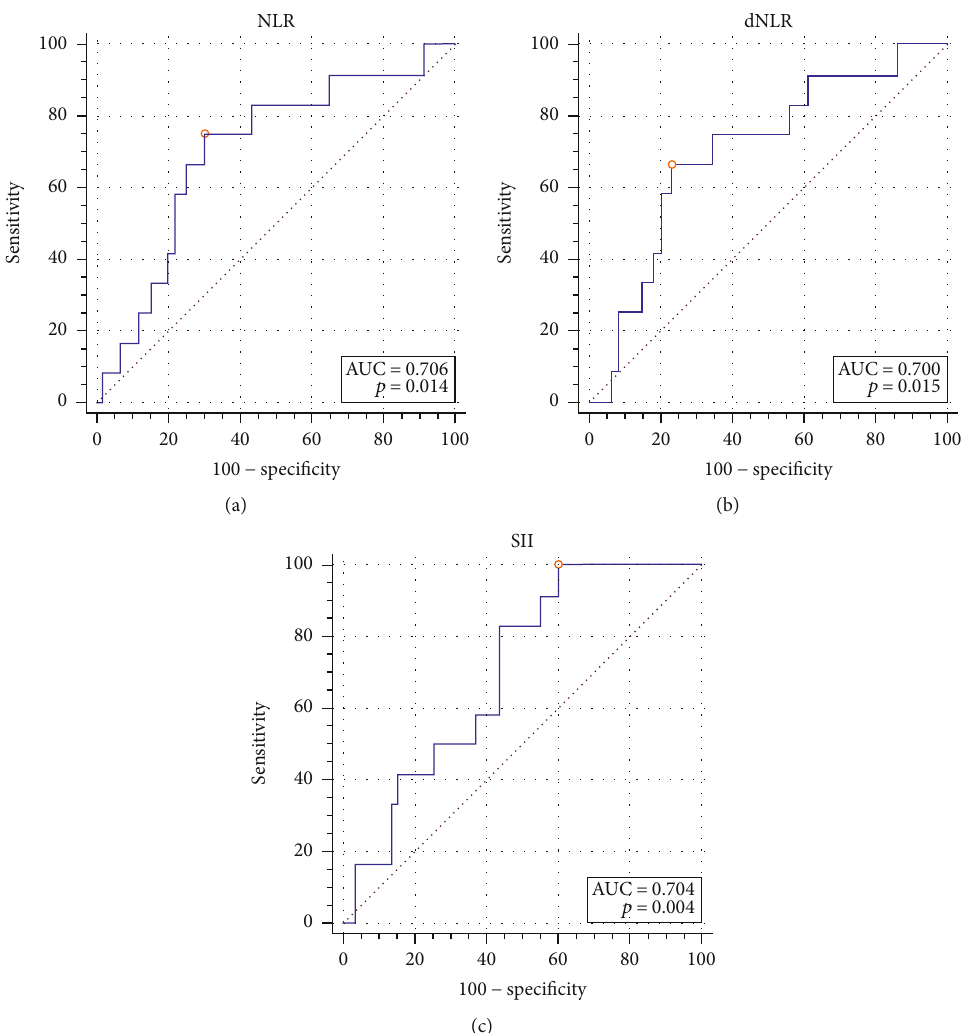
Figure 1: The receiver operating characteristic curves of NLR, dNLR, and SII for lymph node metastasis. (a) NLR had an acceptable diagnostic value for lymph node metastasis when the cut-o ff value was 3.12 ( AUC = 0 : 706 , sensitivity = 75 : 00 % , specificity = 70 : 00 % , P = 0 : 014 ). (b) dNLR had an acceptable diagnostic value for lymph node metastasis when the cut-o ff value was 2.49 ( AUC = 0 : 700 , sensitivity = 66 : 67 % , specificity = 76 : 67 % , P = 0 : 015 ). (c) SII had an acceptable diagnostic value for lymph node metastasis when the cut-o ff value was 463.56 ( AUC = 0 : 704 , sensitivity = 100 : 00 % , specificity = 40 : 00 % , P = 0 : 004